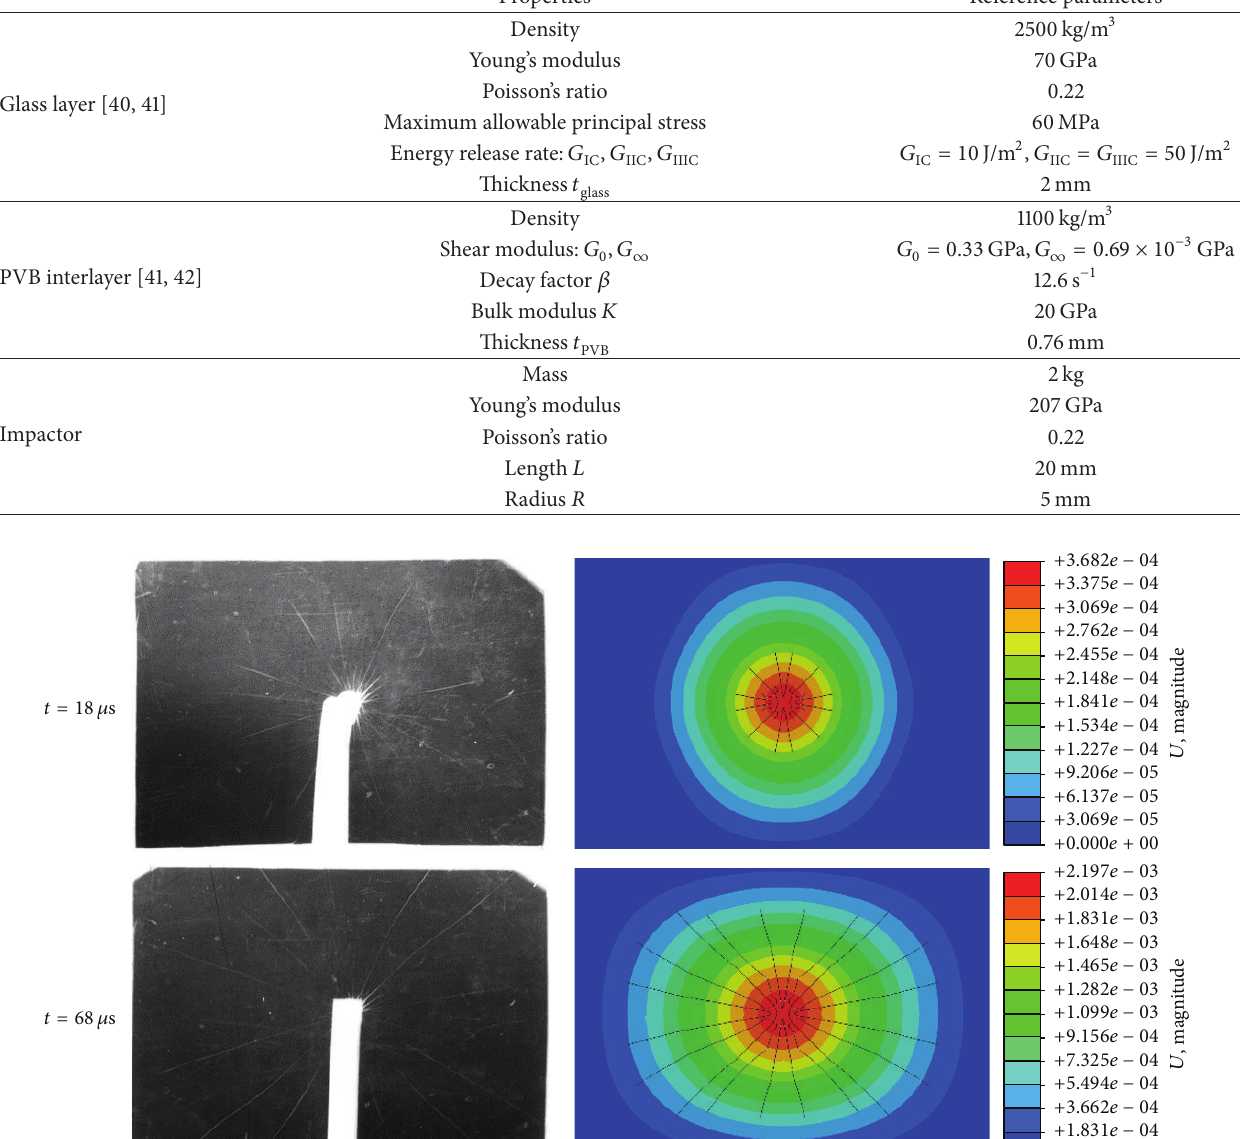
Table 1: Basic parameters for numerical model.